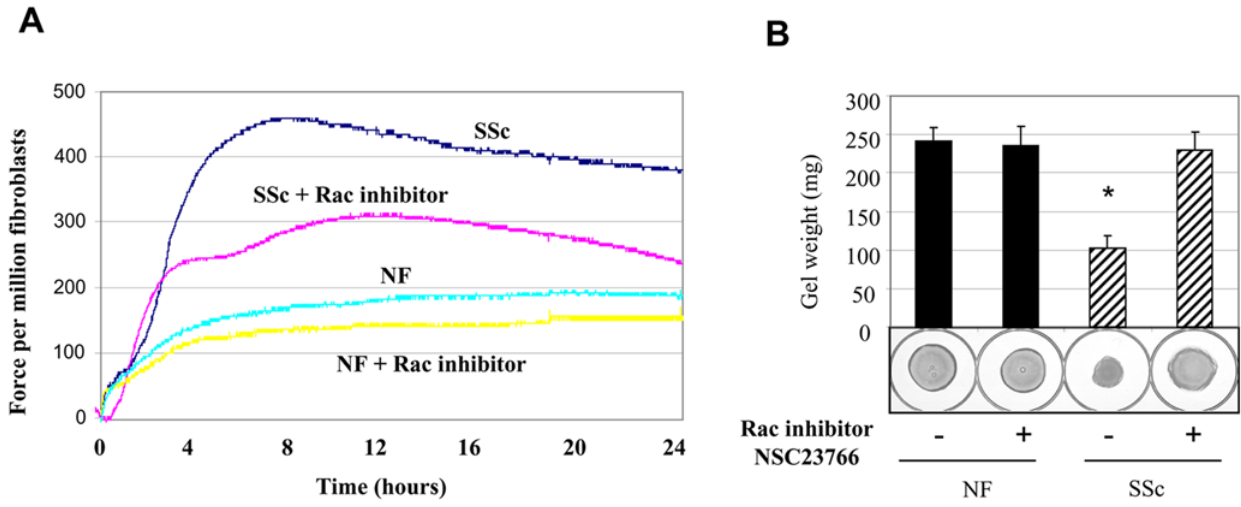
The effect of rac inhibition on ECM contraction over 24 hours generated by fibroblasts embedded in a floating collagen gel matrix was evaluated. Contraction was assessed photographically and by measuring gel weight iameter of contracted gels (n=6; Average + / 2 standard deviation is indicated; *=p , 0.05, statistically different from control untreated normal fibroblasts, ANOVA). Note that NSC23766 suppressed the enhanced ECM contraction by lesional SSc fibroblasts.